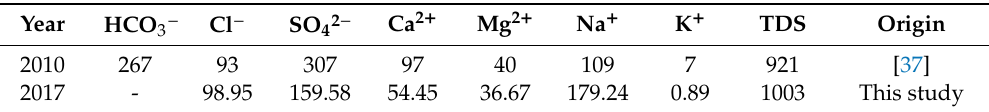
Table 3. Changes of groundwater hydrochemical characteristics in the Minqin Basin in 2010 and 2017 (Unit: mg L − 1